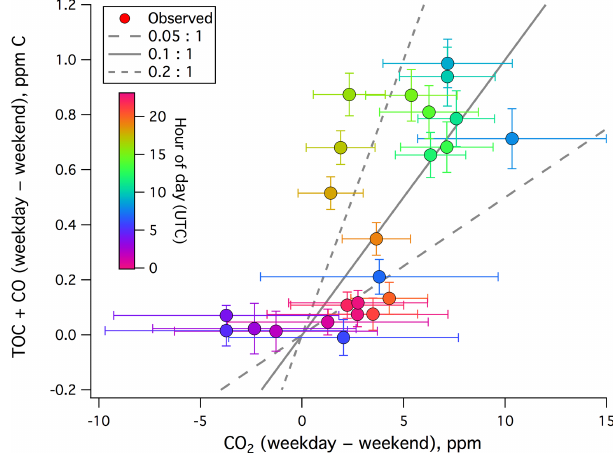
Figure 5. Weekday–weekend difference in TOC + CO (ppmC) vs. weekday–weekend difference in CO 2 from the rooftop of Plymouth Marine Laboratory. A positive correlation is observed, with a di- mensionless ratio ranging from mostly less than 0 . 05 : 1 to over 0 . 2 :